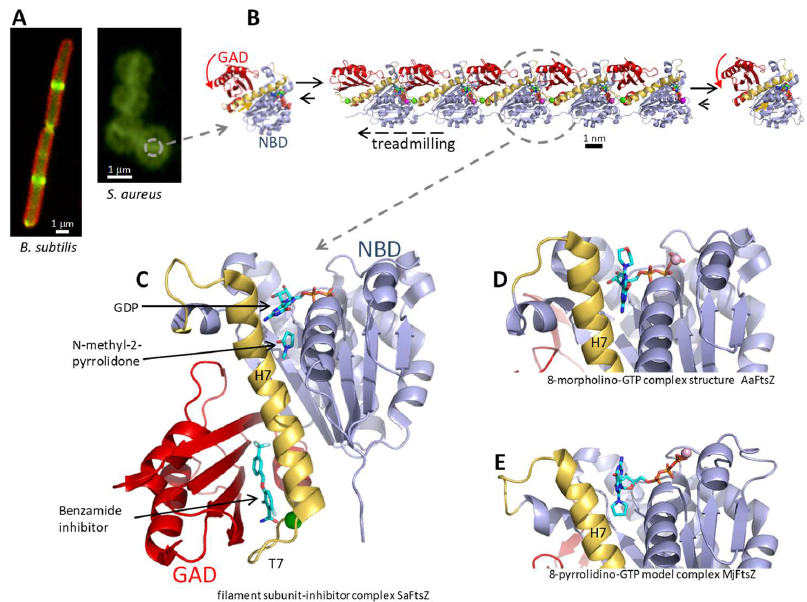
Figure 1. ( A ) Left, B. subtilis cells expressing FtsZ-GFP (green), with the membrane stained with FM4-64 (red); right, S. aureus cells treated with a fluorescent FtsZ probe (green, [25]) to visualize FtsZ rings. Scale bars: 1 µ m. ( B ) Filament structure of FtsZ from S. aureus , represented by a pentamer (PDB 6RVN, [30]), with the treadmilling direction indicated by the arrow. One incoming monomer (left) and one dissociated monomer (right) are also shown. Scale bar: 1 nm. ( C ) Structure of one SaFtsZ filament subunit (cartoon representation). The N-terminal NBD is colored blue, the central helix H7 and its flanking loops yellow, and the C-terminal GAD red. The bound GDP nucleotide, a co-solvent molecule and one benzamide allosteric inhibitor are shown (sticks colored by atom type) [PDB 6YD6, [16]]. ( D ) AaFtsZ monomer in complex with 8-morpholino-GTP [PDB 2r7l, [10]]. ( E ) MjFtsZ monomer in complex with 8-pyrrolidino-GTP; NMR-based ligand model after docking and MD of the protein complex (adapted with permission from [48]; copyright 2013 American Chemical Society). All structural images displayed were prepared with PyMol [49].